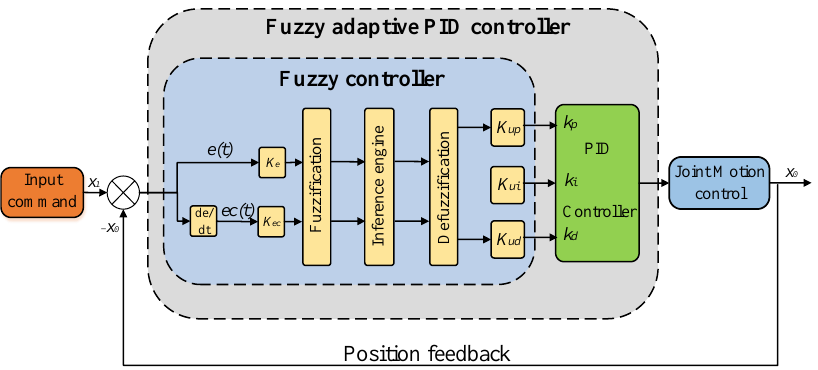
Figure 4. Fuzzy adaptive PID controller control block diagram.